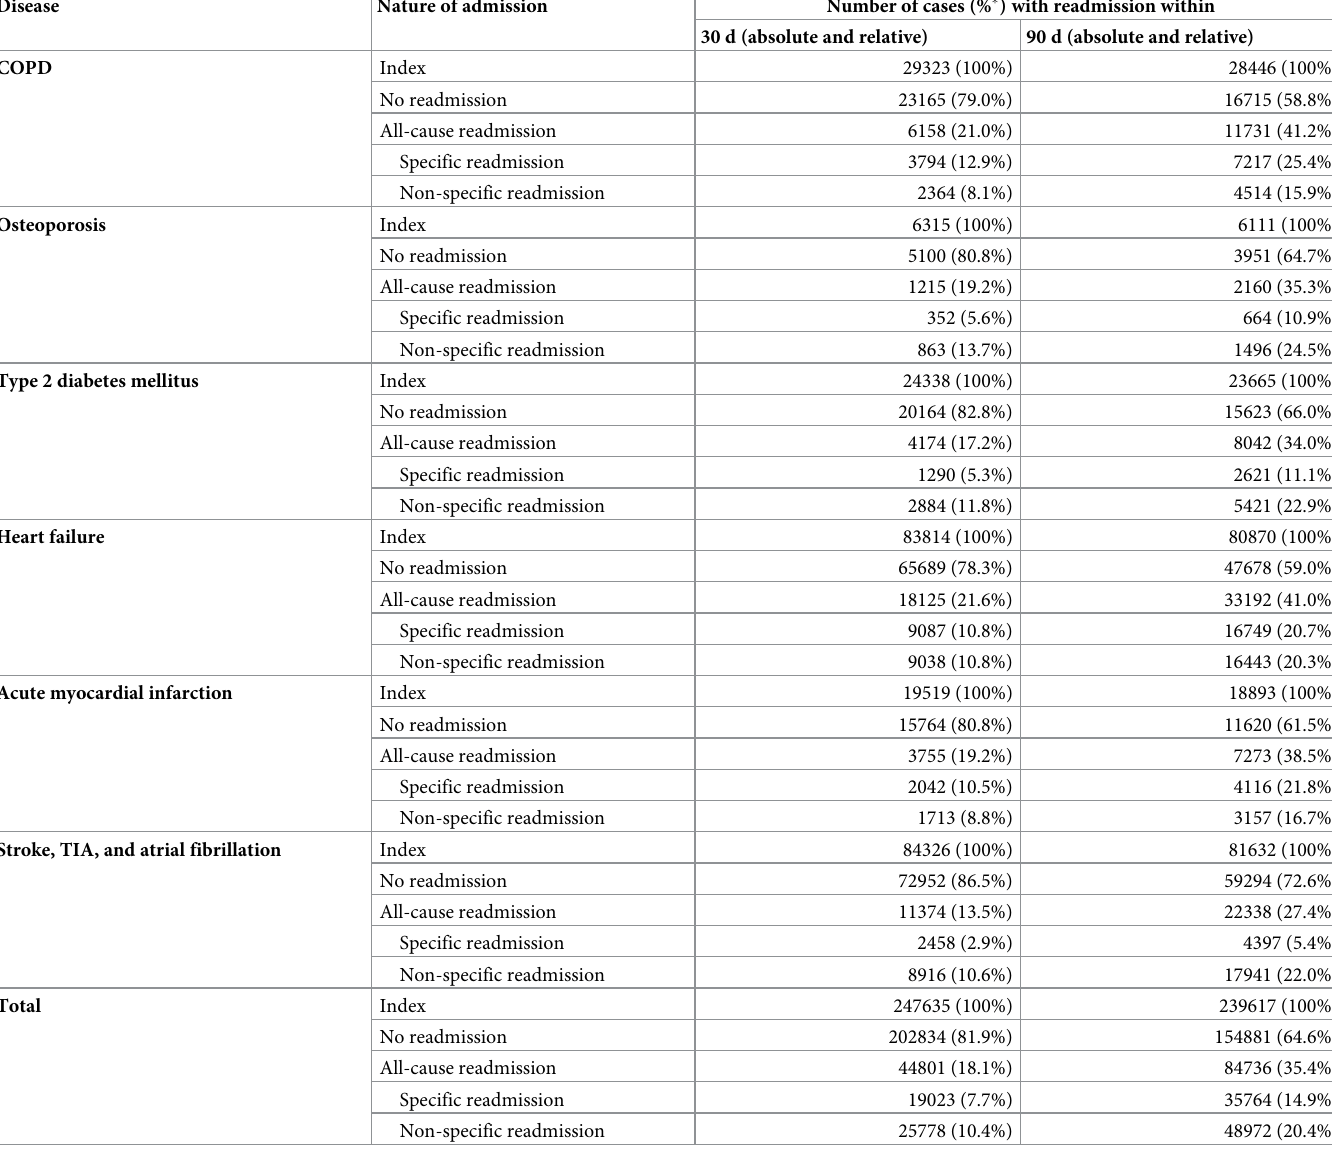
Table 1. Number and proportion of hospital admissions and readmissions for the years